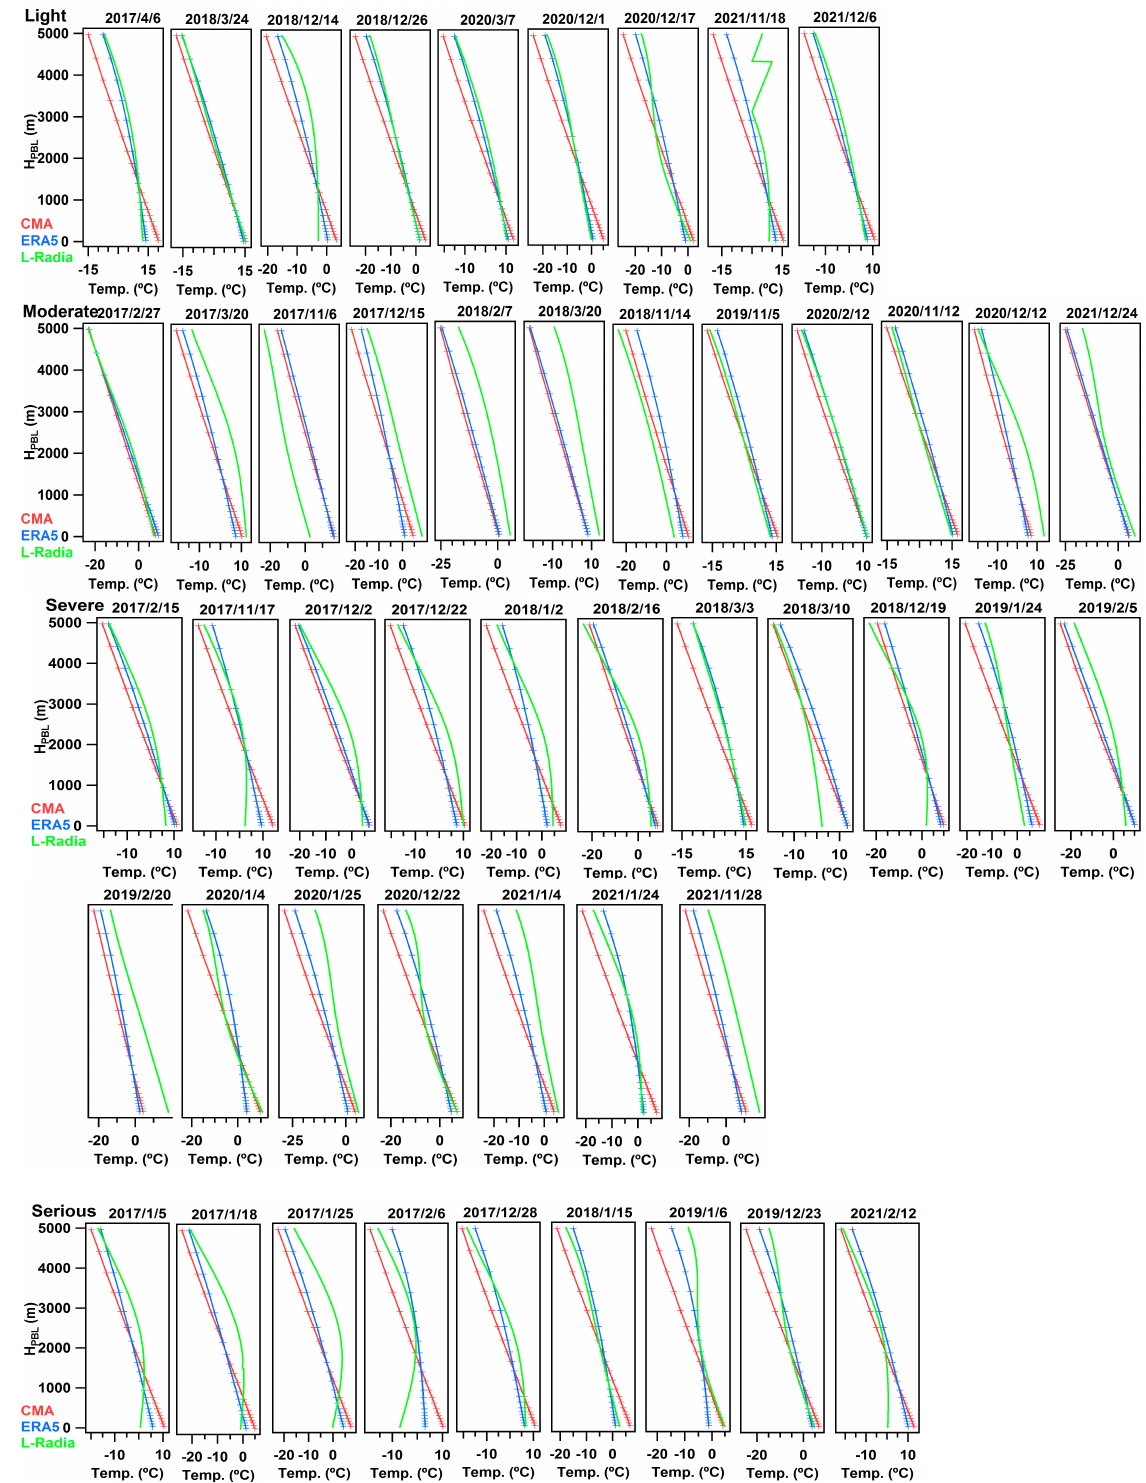
Figure 7. The vertical profiles of CMA, ERA5 and L − band radiosonde sounding temperature in peak concentration days under di ff erent levels of PM 2.5 pollution processes.